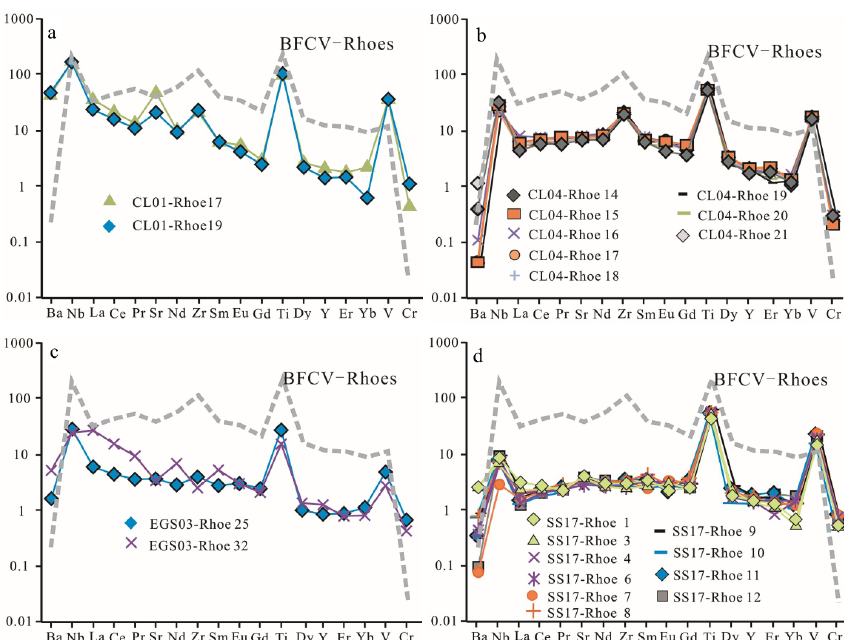
Figure 9. Spidergrams of rhönite normalized to primitive mantle (Sun and McDonough, 1989) and compared to rhönite from islands of Bravo and Fogu, Cabo Verde archipelago (BFCV–Rhoes), from Kogarko et al. (2005).